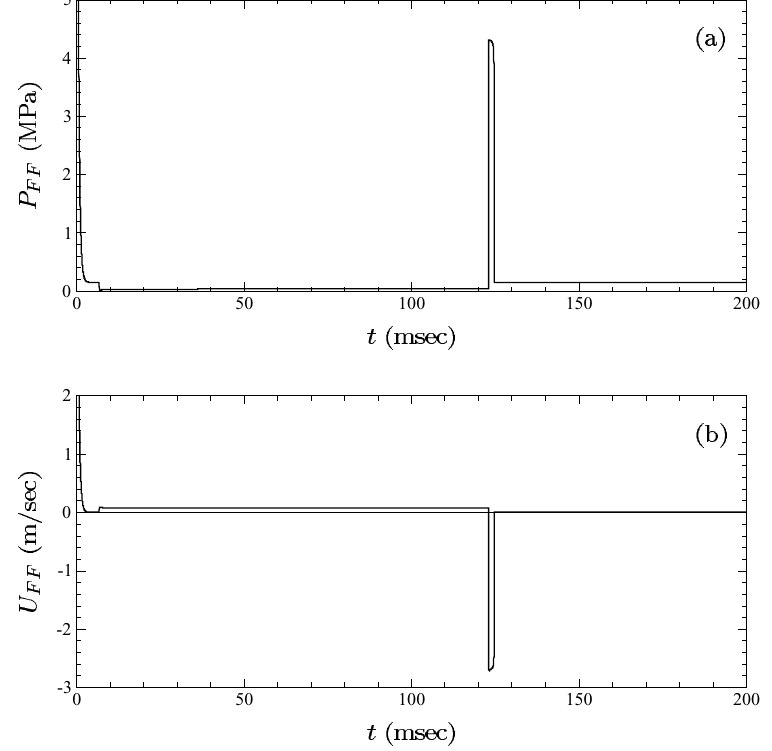
Fig. 3. Free-field results used in the WSA calculations. Free-field (a) absolute pressure and (b) velocity at the CAFE node 5.08 m below the surface.